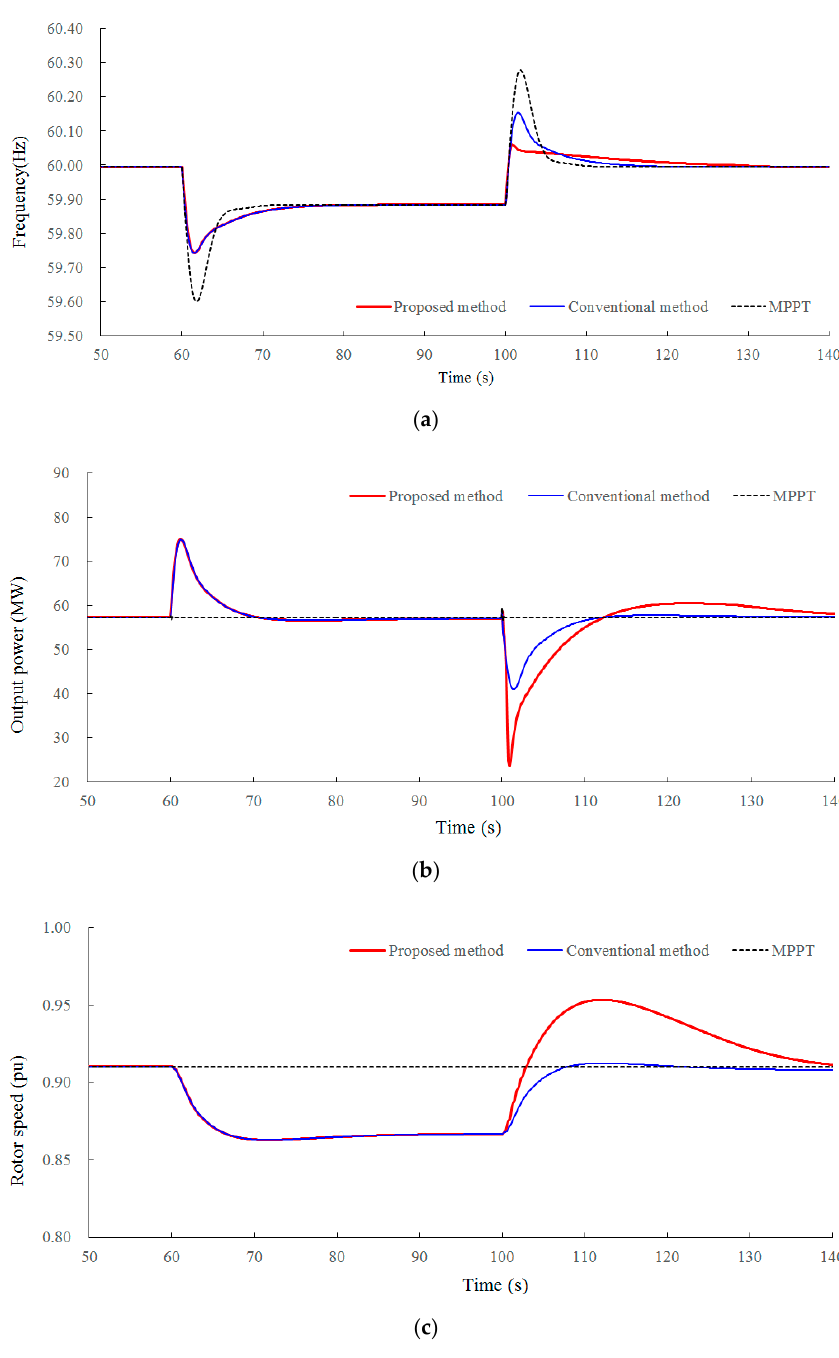
Figure 10. Simulations for Case 5: ( a ) System frequencies; ( b ) Active powers; ( c ) Rotor speeds.